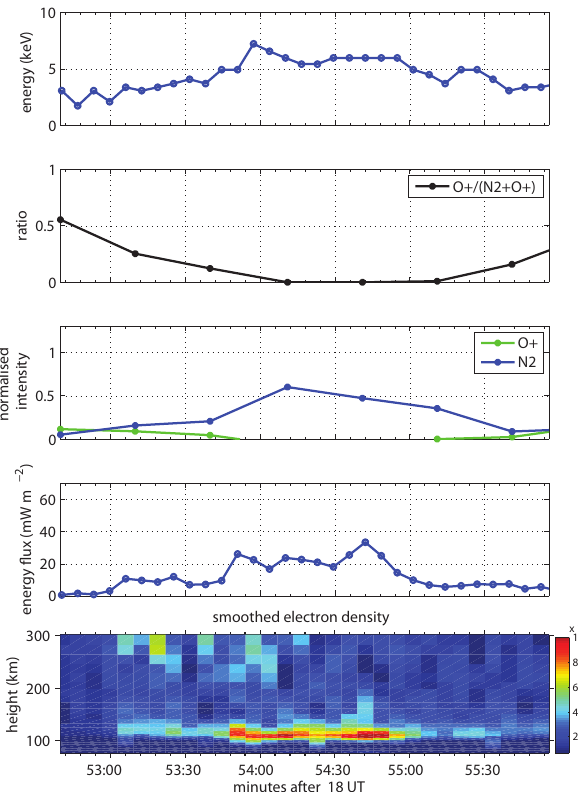
Fig. 11. Electron transport model results compared with optical re- sults: Panel 1: peak electron energy for event 4, when assuming the input electron spectrum at the top of the ionosphere to be monoen- ergetic, Panel 2: O + /(O + +N 2 ) ratio, Panel 3: O + intensity (green) and N 2 intensity (blue), Panel 4: fitted energy flux below 150km, Panel 5: Smoothed electron density height